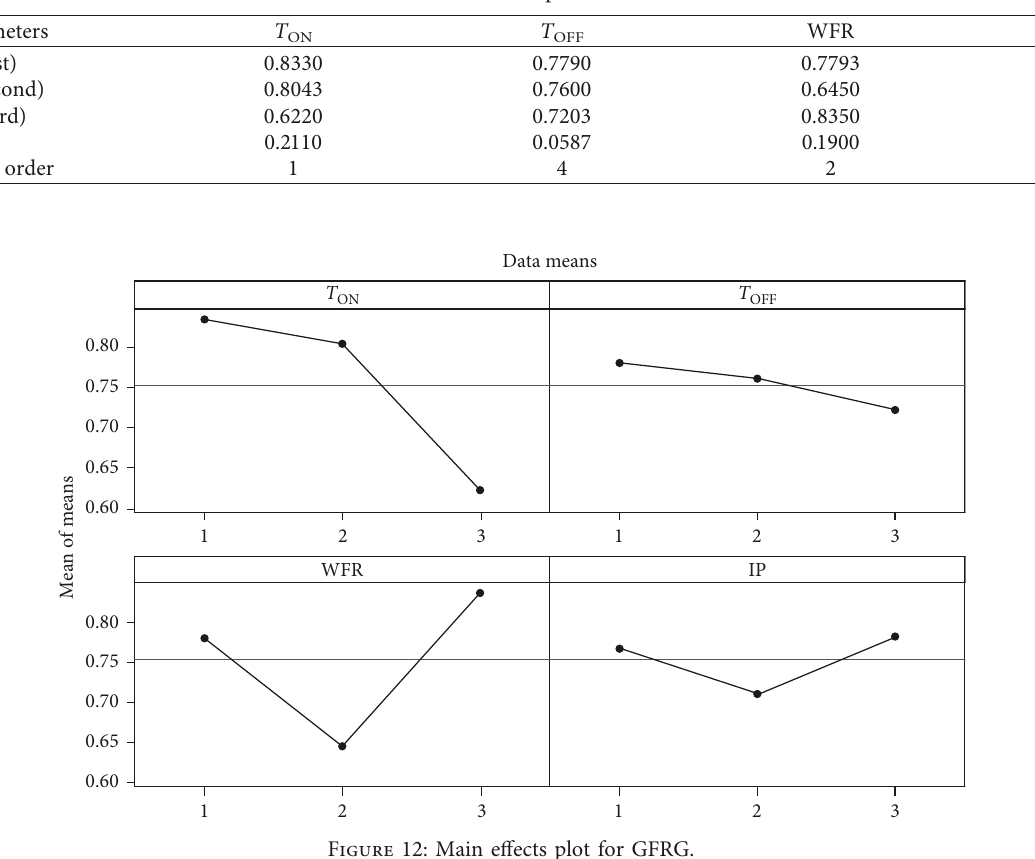
Table 9: GFRG response